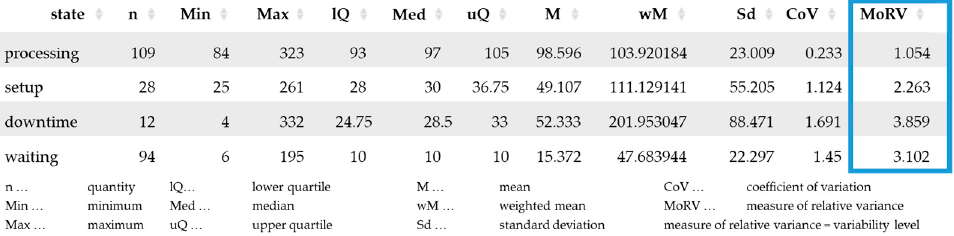
Figure 13. Example of the results of test series one, wherein the variability levels are marked in color.